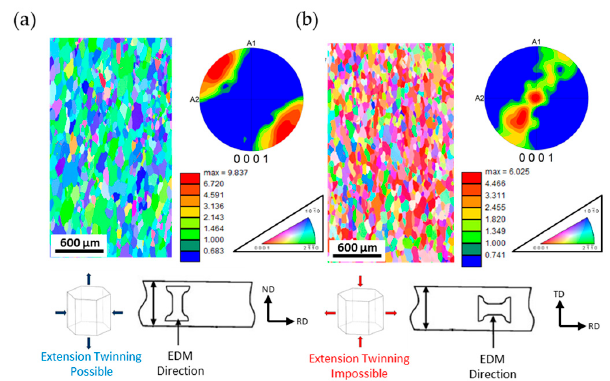
Figure 3. Microstructure of tensile specimens: EBSD map and corresponding pole figures of: ( a ) ND orientation; ( b ) RD orientation.